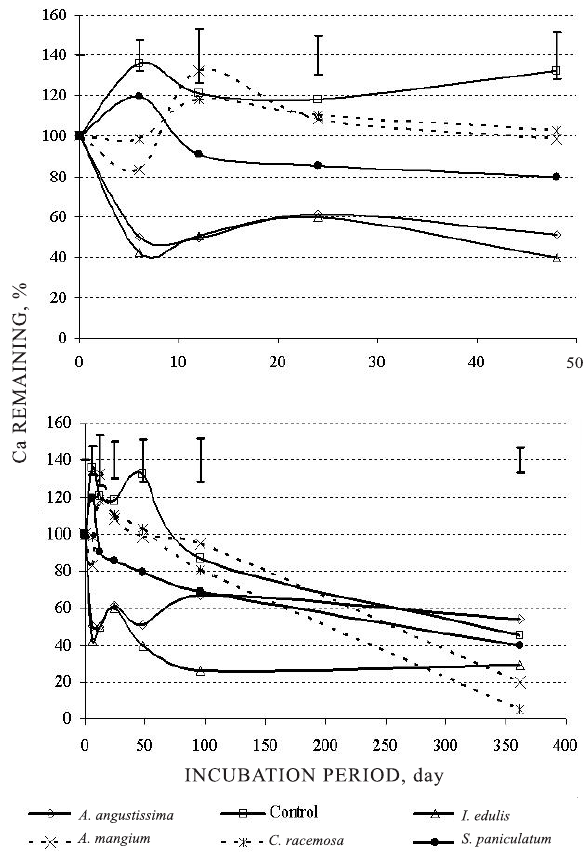
54Figure 6. Percentages of Ca remaining in mulch from different enriched legumes trees and natural fellow as control, for 48 and 362 days of incubation period. Bars represent LSD with p <